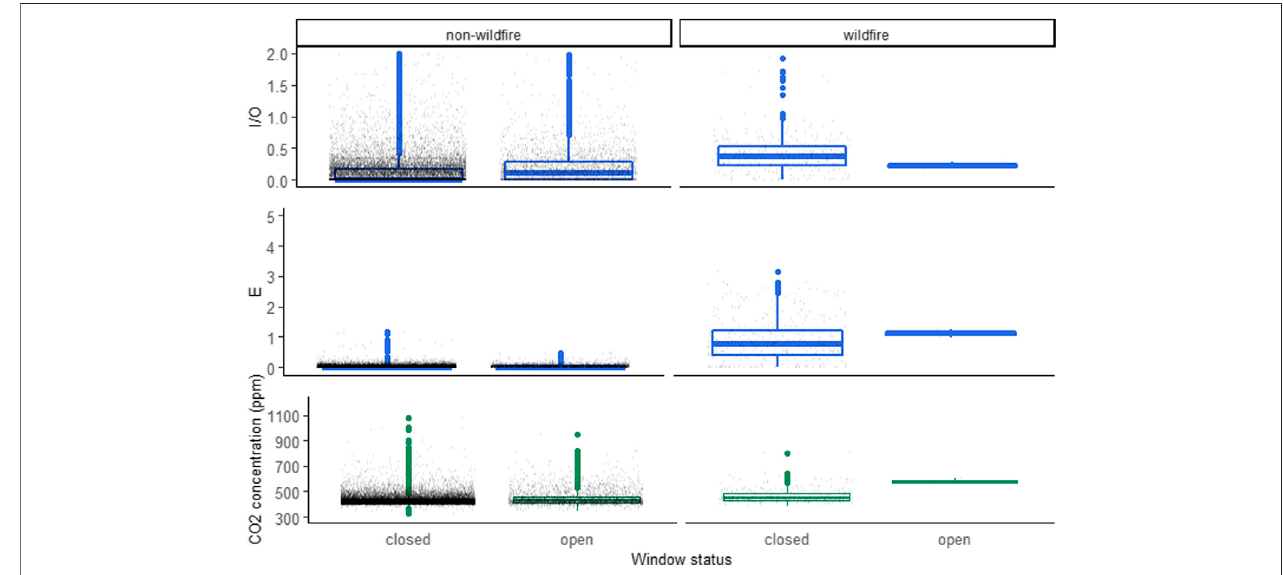
FIGURE 8 | Window status and indoor PM 2.5 and CO 2